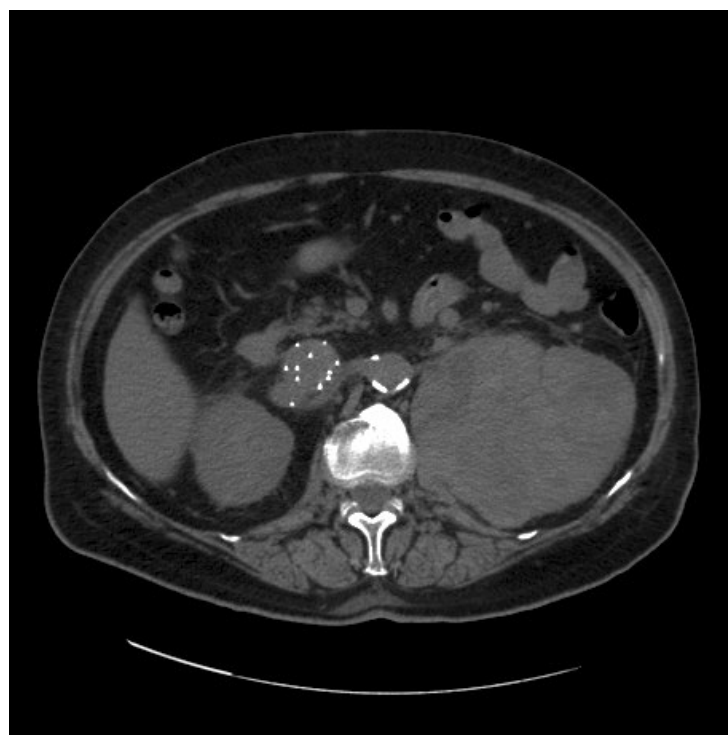
FIGURE 2 . Transverse view of